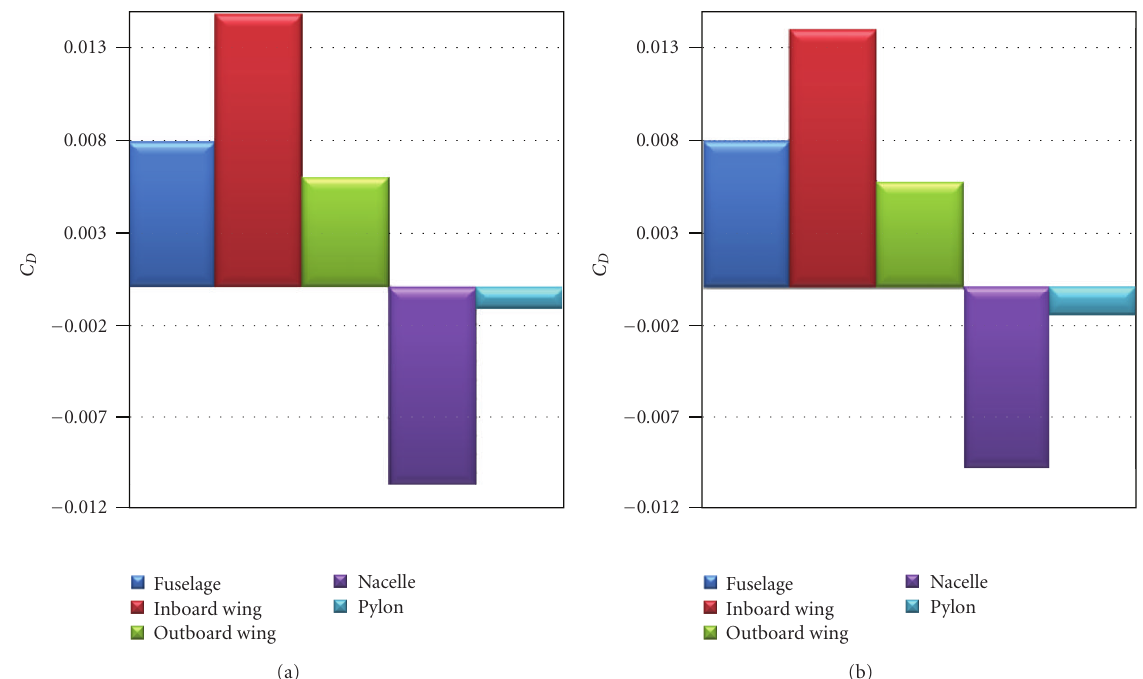
Figure 20: Proportion of pressure drag coe ffi cient ((a) OPT1 , (b) OPT2 ).